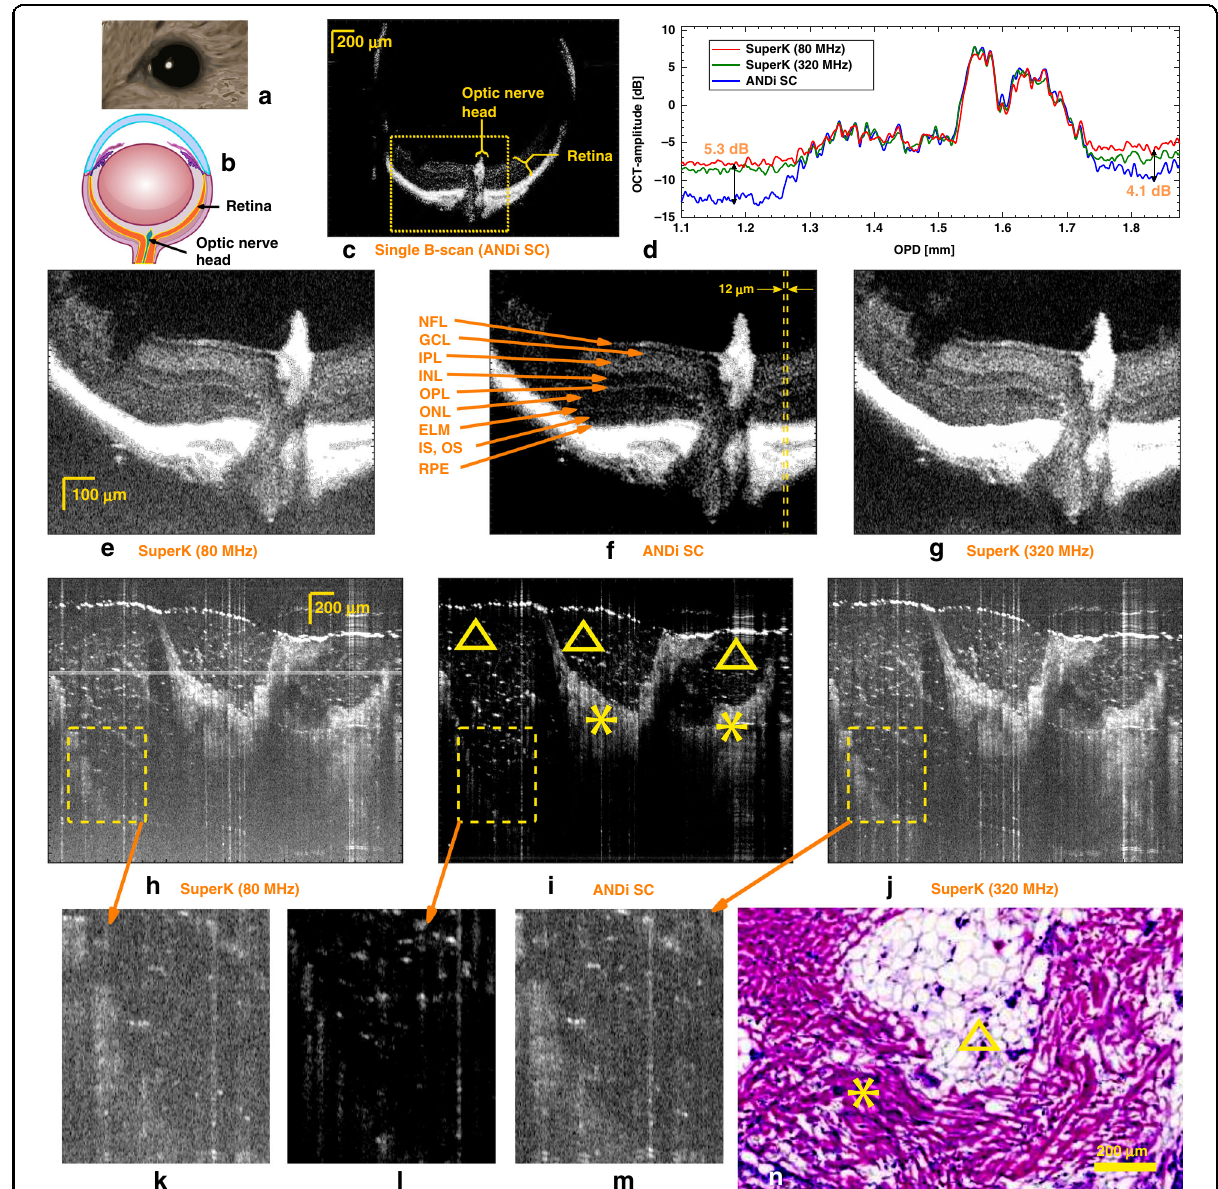
Fig. 4 OCT imaging of rat eye and human fat tissue. Ex vivo rat-eye imaging: Artistic image of a mouse eye ( a ) with a cross-sectional schematic shown in ( b ). Single B-scan OCT image in depth of a 1.95 × 2.62 mm section of a mouse retina obtained using the ANDi SC source ( c ). Averaged A-scans (averaged over 4 equally spaced A-scans) from the marked region in ( f ) for the three sources ( d ). Zooms of the retina and optic nerve in the area marked by a yellow box in ( c ) using the 80 MHz SuperK extreme ( e ), ANDi SC ( f ), and 320 MHz SuperK extreme ( g ) sources (all averaged over 9 B-scans). NFL nerve fi ber layer, GCL ganglion cell layer, IPL inner plexiform layer, OPL outer plexiform layer, ONL outer nuclear layer, ELM external limiting membrane, IS, OS inner segments, outer segments of the photoreceptors, and RPE retinal pigment epithelium. Ex vivo imaging of human fat tissue : 1.9 × 3 mm human skin biopsy averaged over nine single B-scans, obtained using the 80 MHz SuperK extreme ( h ), ANDi SC ( i ), and 320 MHz SuperK extreme ( j ) sources. Histology of fat tissue ( n ). Triangles and stars mark tissue types of cutaneous fat tissue and connective tissue of reticular dermis,